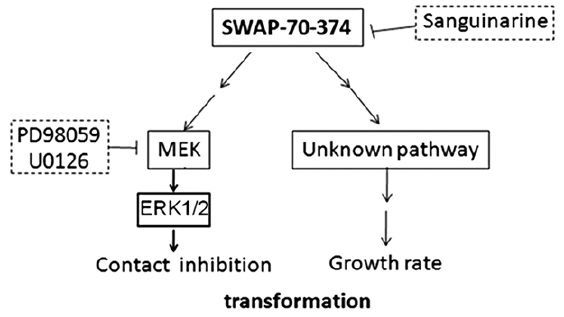
Figure 8. Effect of sanguinarine and MEK inhibitors on growth of SWAP-70-374-transformed cells. A, A confluent culture of 18-2 and SWAP-70-374-2 cells were replated to fresh dishes and cultured for 1day in the presence or absence of sanguinarine (0.8 m M). The cells were lysed and analyzed for phosphorylation of ERK1/2. Left half, probed with an anti-phospho-ERK1/2 antibody. Right half, probed with an anti-ERK1/2 antibody. B, SWAP-70-374-2 cells (2 6 10 5 cells/6-cm dish)